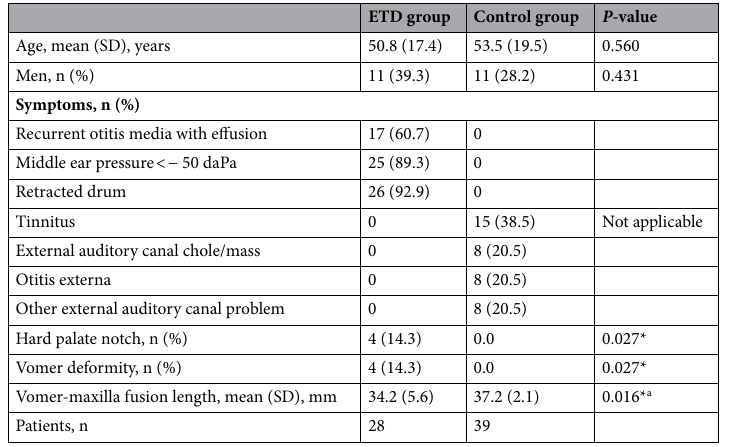
Table 1. Comparative evaluation of the ETD and control groups. ETD Eustachian tube dysfunction, SD standard deviation. * P -value < 0.05. a Mann–Whitney test.